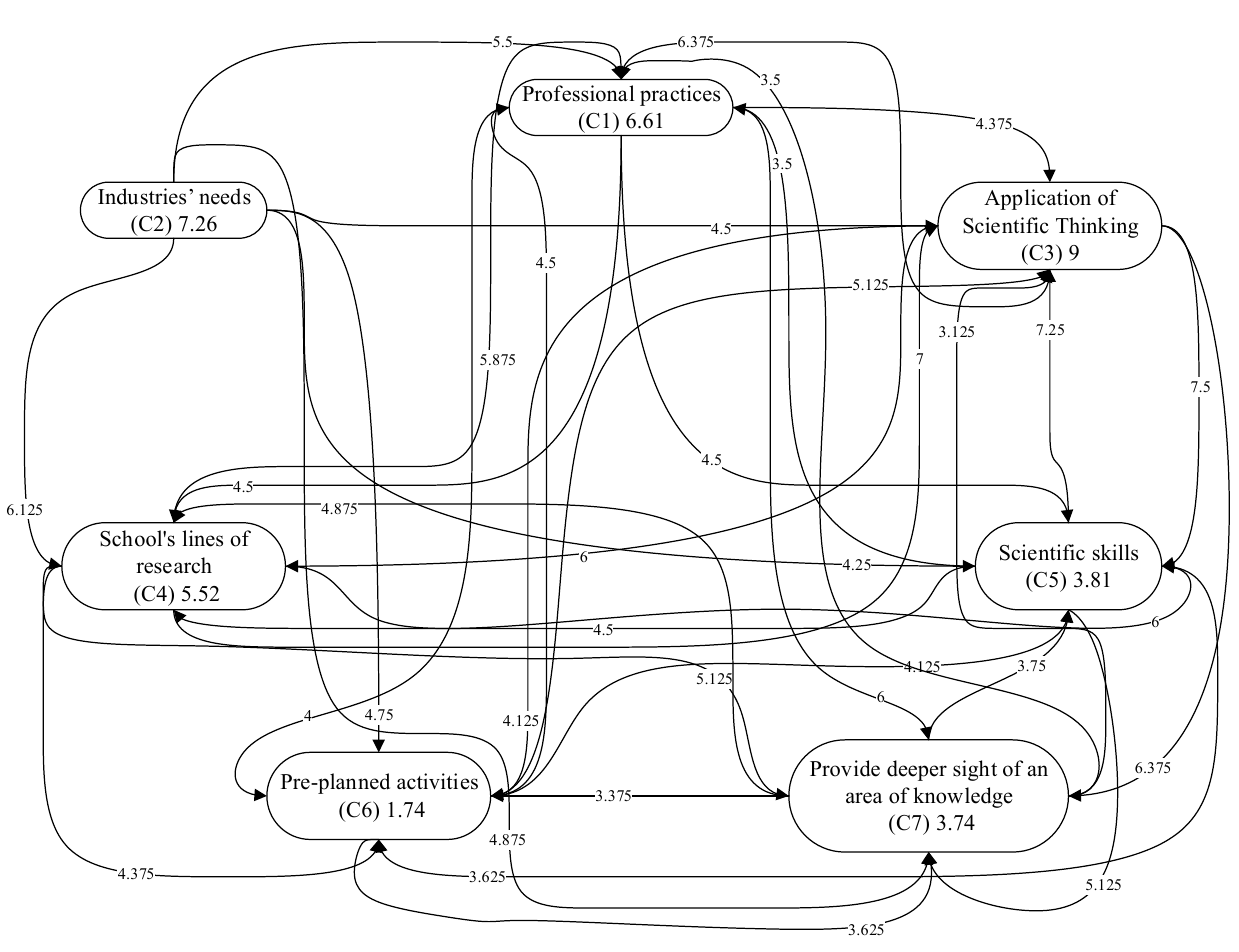
Figure 2. Criteria interaction causal map.